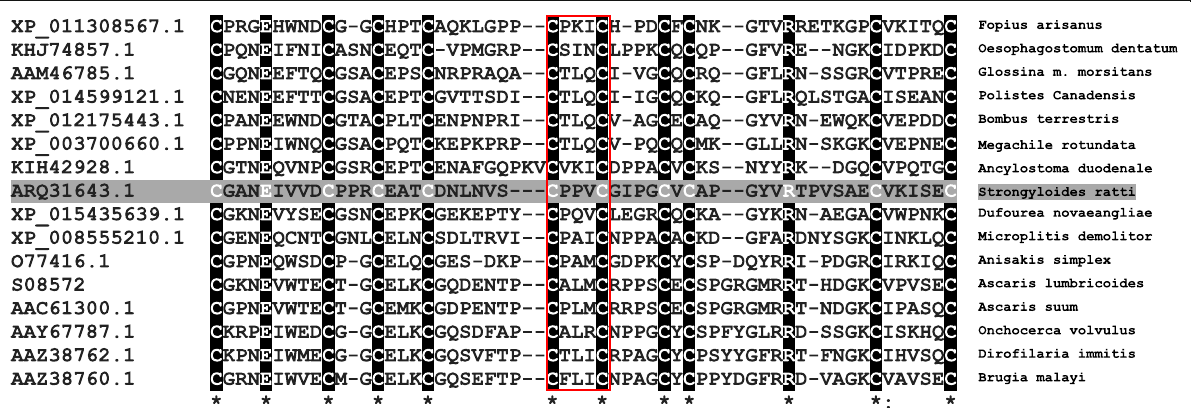
Fig. 4 CLUSTAL multiple sequence alignment by MUSCLE (3.8) of selected 16 aa sequences of TIL domains in some nematodes (including the Sra -TIL domain which is highlighted in gray) and arthropods. Samples are labeled according to the GenBank accession numbers (left) and name of species (right). Symbols: identical (asterisks; black highlighted) and no aa (dashes). The active inhibitory site is labeled with red boundary